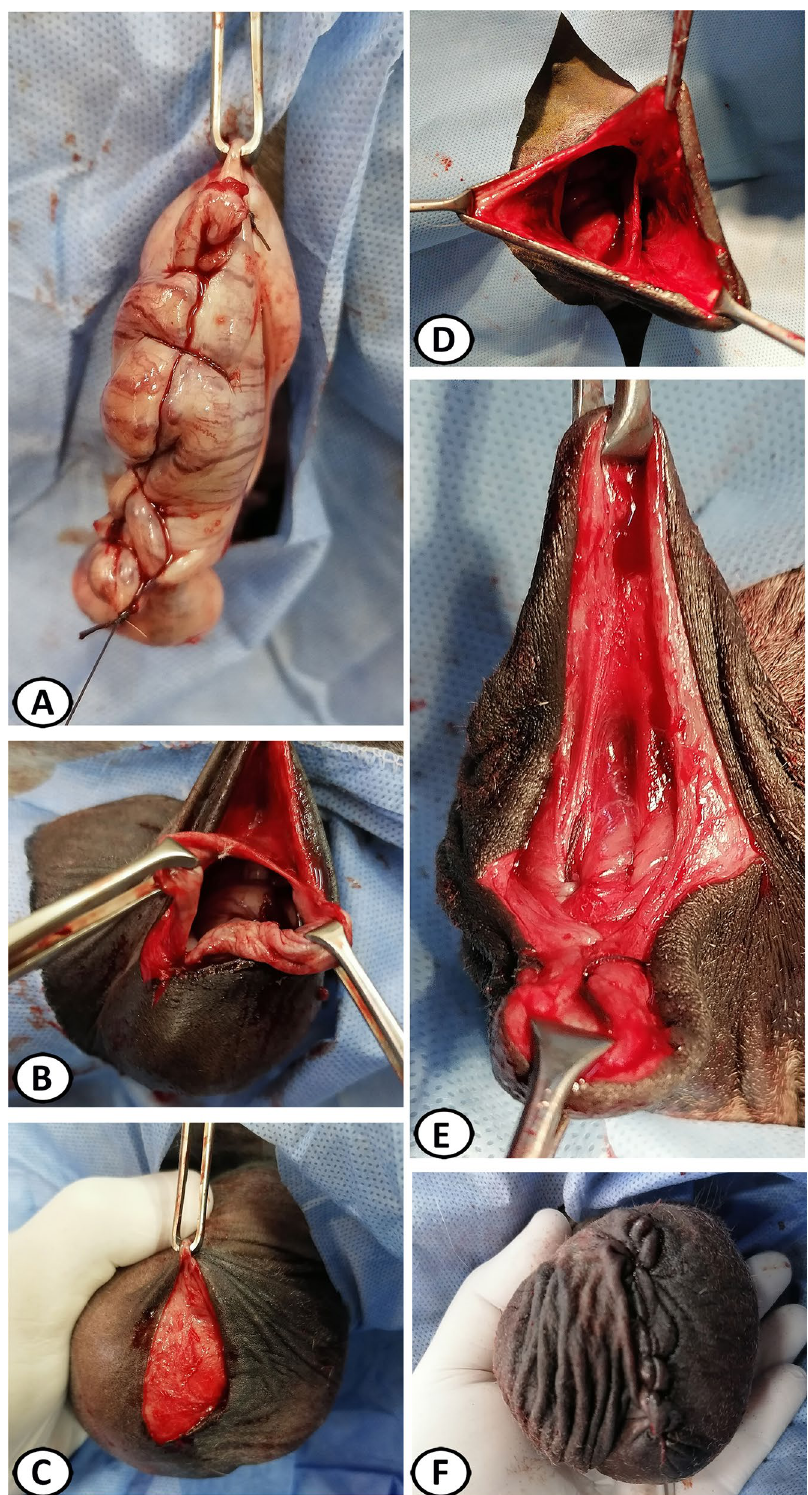
Figure 2. Subcapsular castration (SC) in donkeys. ( A ) Closing of the albuginea and visceral vaginal tunic. ( B ) The operated testicle returned into its pouch. ( C ) Access to the second testicle by cutting the median sagittal septum, entering the vaginal cavity of the first scrotal pouch while comprising it. ( D ) The second operated testicle returned into its pouch. ( E ) Closing of the median sagittal septum and the opened scrotal pouch, formed by internal spermatic fascia and parietal vaginal tunic. ( F ) Closing of the scrotal